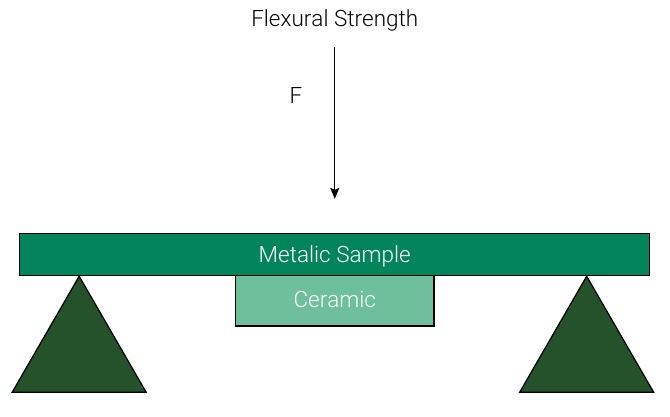
Flexural Strength